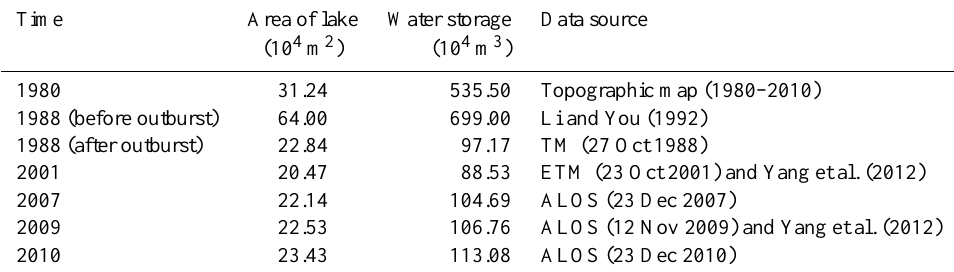
Table 3. The parameters of the Guangxieco Lake in 1980, 1988, 2001, 2007, 2009 and